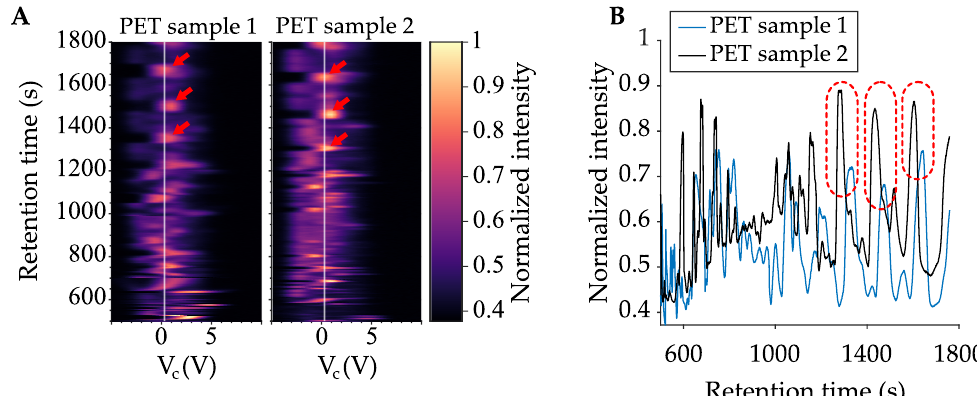
Figure 5. ( A ) Representative Py-GC/DMS data for two PET samples analyzed 3 months and 15 days apart with the same system, between which the system was used on other samples. ( B ) Ion intensity (V) at the electrometer is plotted versus retention time at a constant V C [V C = 0.3 V, drawn as a white line in ( A )]. Three peaks are circled in red and show the correspondence between samples. Red arrows point out the same peaks in the left